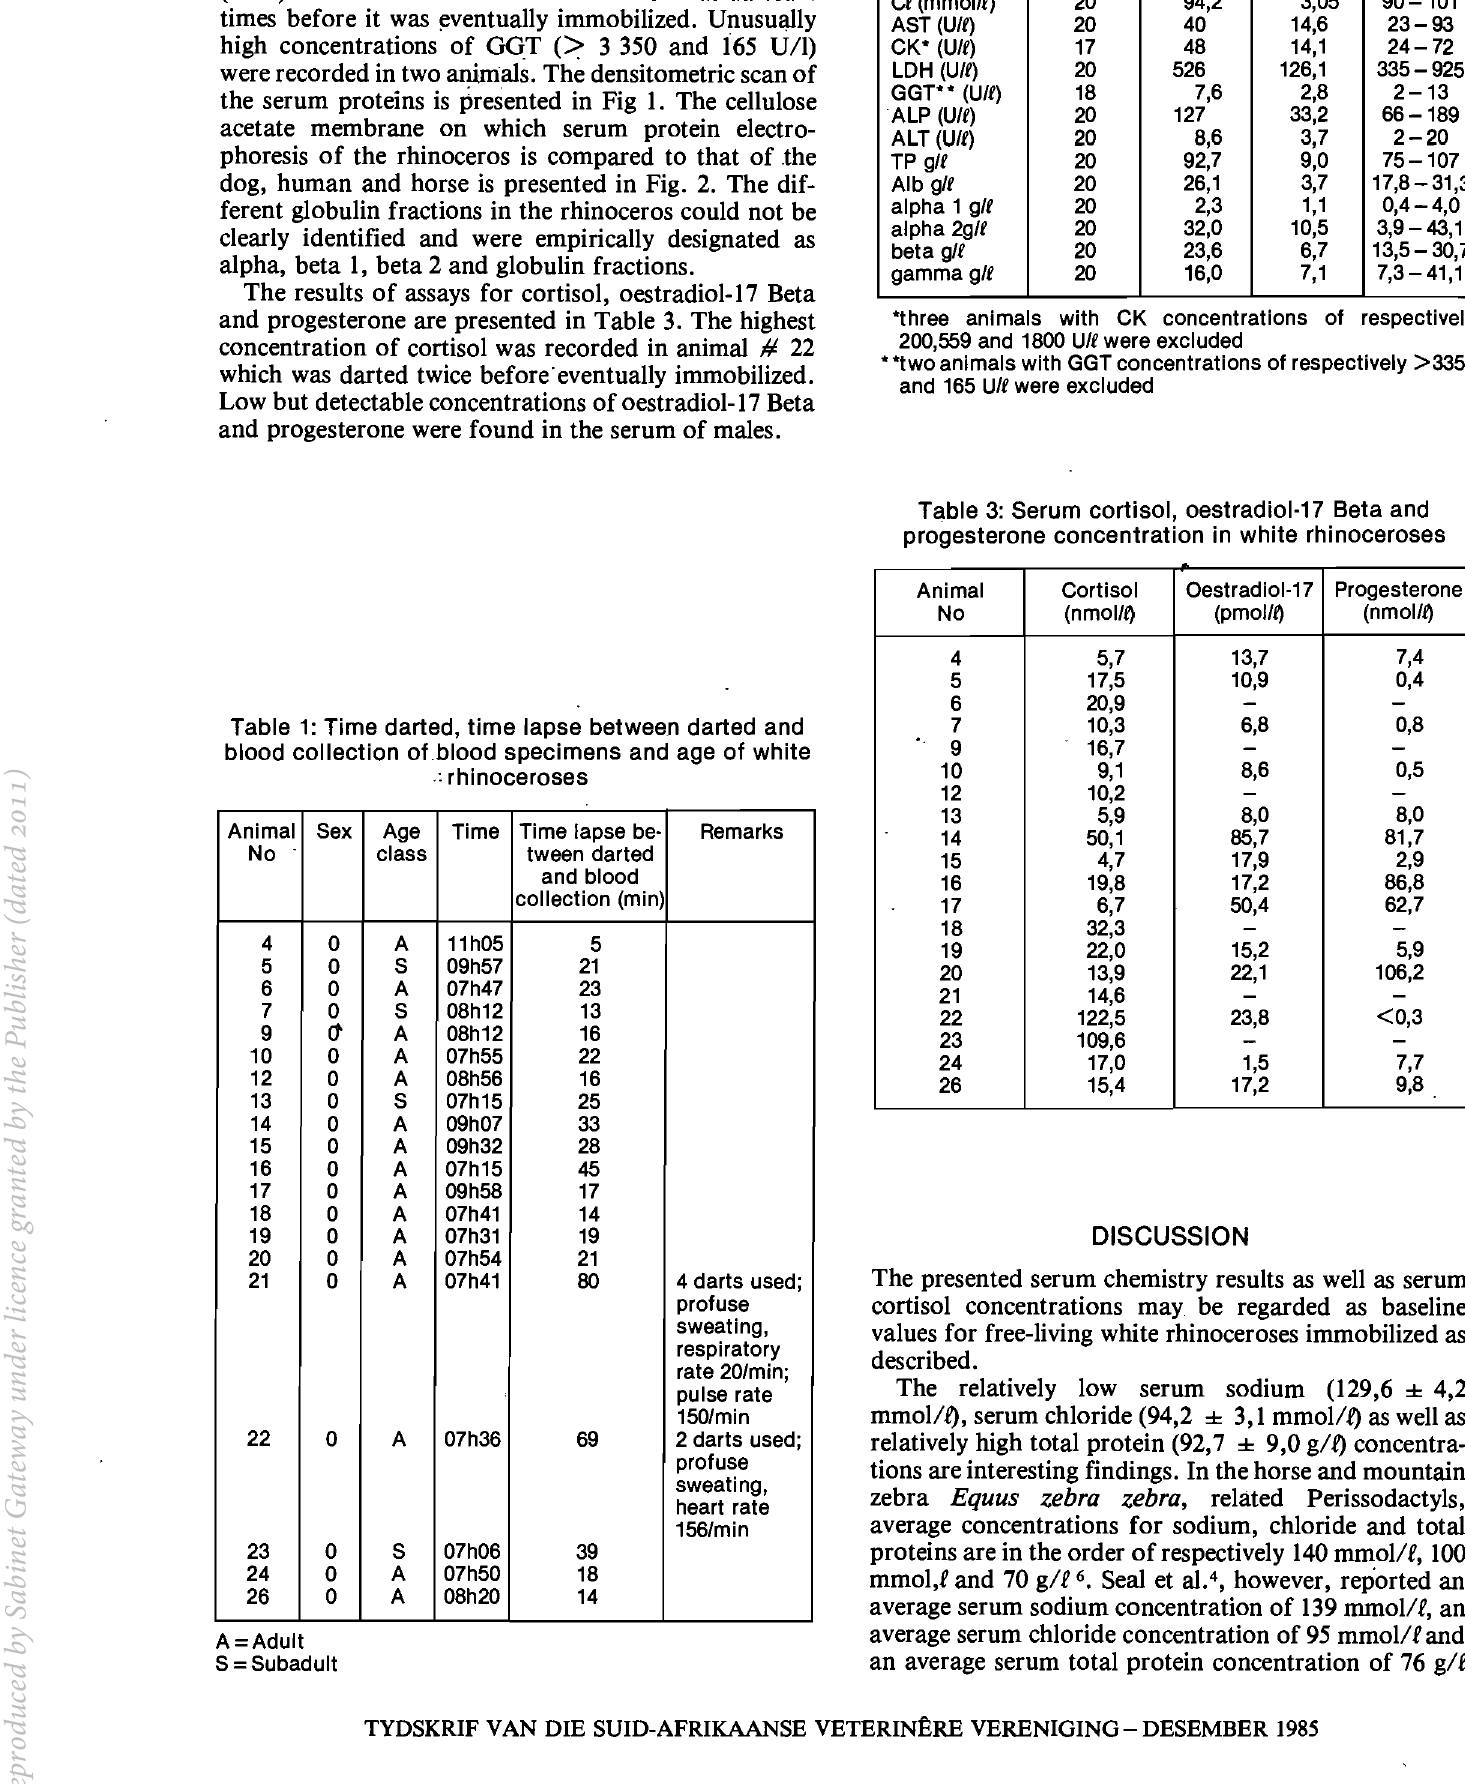
Table 3: Serum cortisol, oestradiol·17 Beta and progesterone concentration in white rhinoceroses Animal